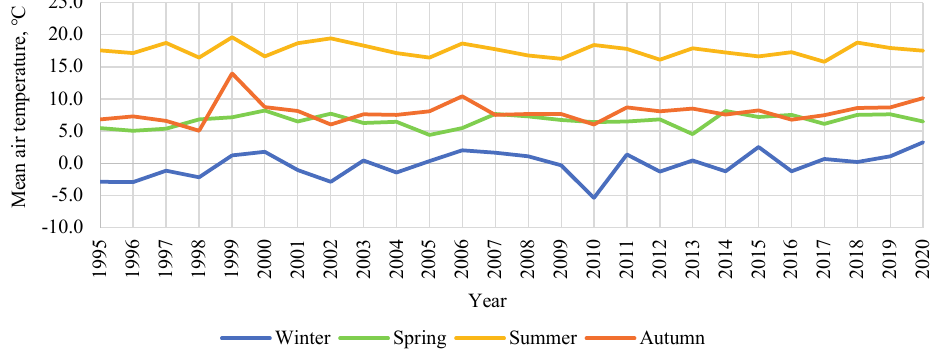
Fig. 3. Mean seasonal air temperature (°C) in the Berze monitoring site, time period 1995–2020. The Berze monitoring site has higher mean air temperature than the rest of monitoring sites not only annually, but also seasonally, e.g., in 1999 the mean air temperature in the autumn was +14 °C, but at the same time no significant temperature differences from other years was observed in other monitoring sites (Fig. 3).